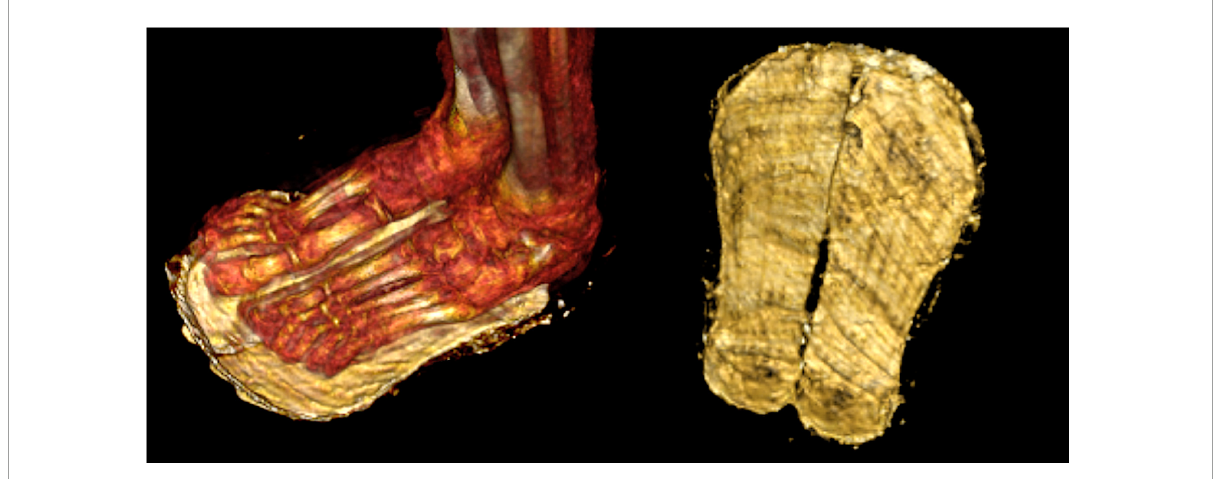
FIGURE13 Three-dimensional (3D) computed tomography (CT) image of the sandal of mummy TR 21/11/16 from the Cairo Egyptian Museum. A pair of open sandals without strips (on the right side) are placed on the soles of the mummy’s feet (on the left side).